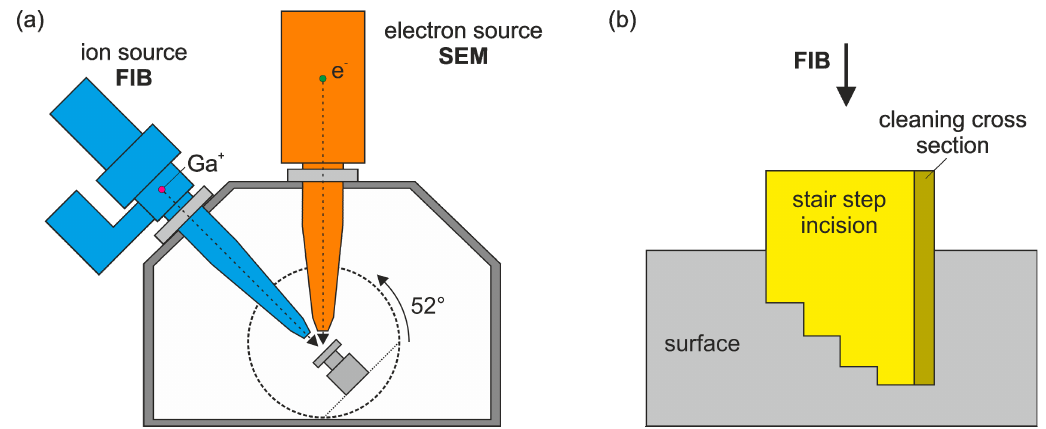
Figure 3. ( a ) Schematic illustration of the SEM/FIB device along with ( b ) the approach used for sectioning of the tool surfaces.